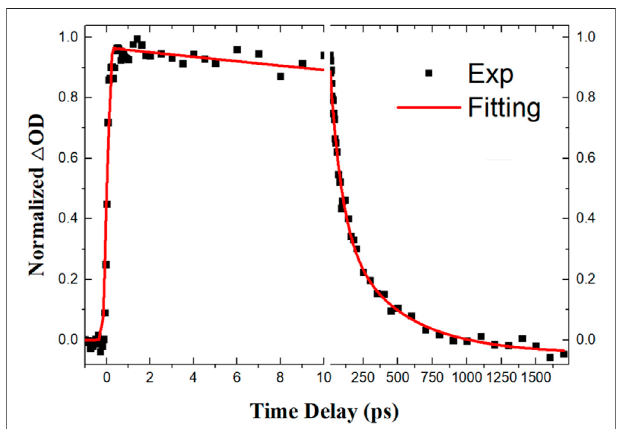
FIGURE 4 | TA decay dynamics extracted at 645.6 nm for multilayer β -GaS thin fi lms. The red lines are theoretical fi tting results.